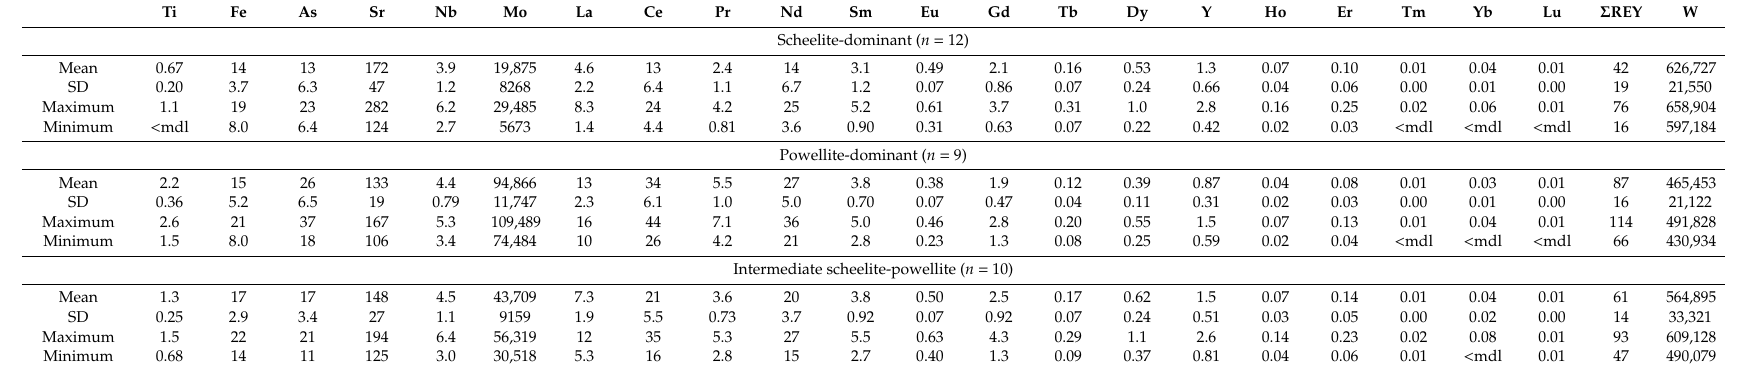
Table 2. Laser ablation inductively coupled plasma mass spectrometry (LA-ICP-MS) data for Zhibula scheelite-powellite